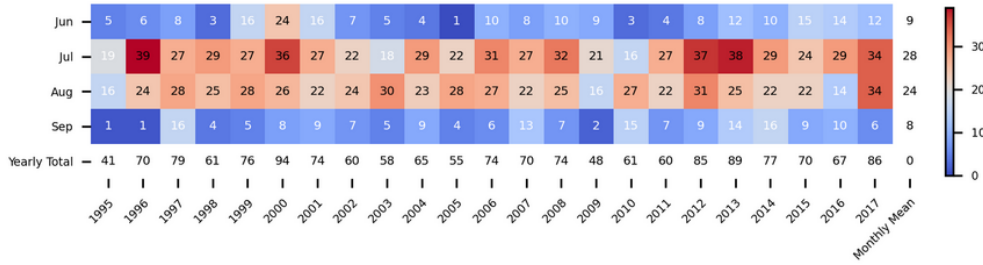
Figure 5. Heatmap of total yearly (bottom row) and monthly MCS counts (grid cells), as well as monthly means MCS counts (far right columns), from 1995 to